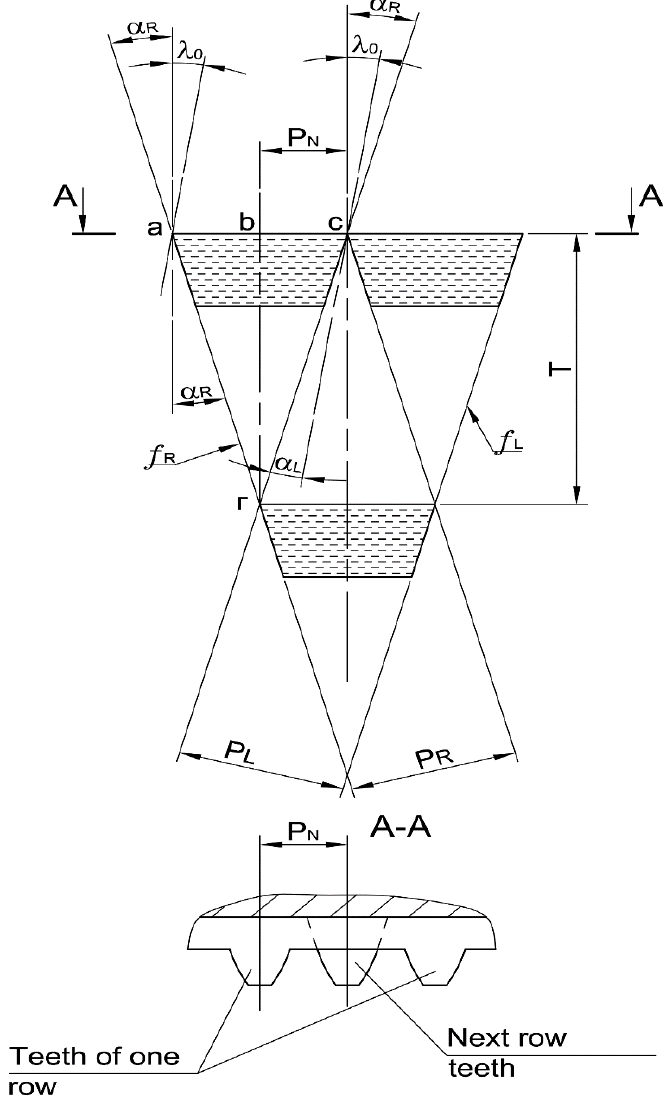
Figure 1. Determination of design parameters of hobs manufactured screw